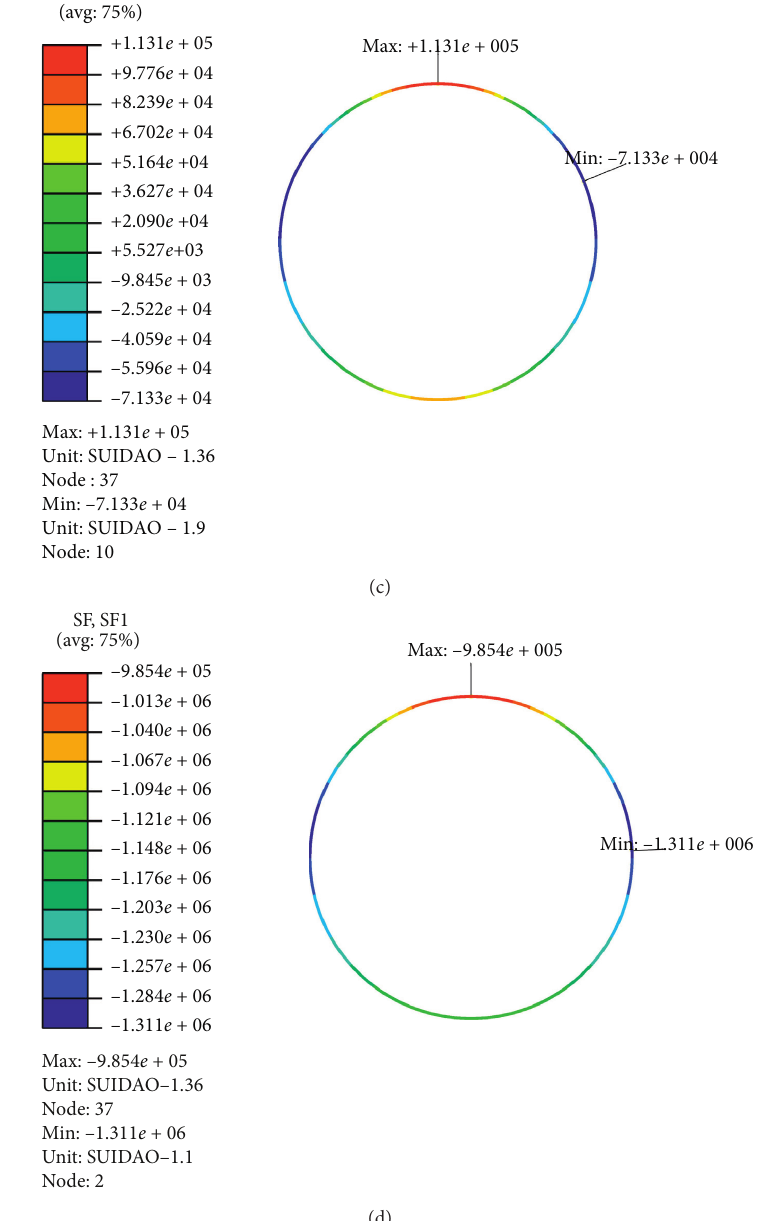
Figure 9: Bending moment and axial diagrams for load mode I. (a) Bending moment diagram under 300kPa (N · m). (b) Axial force diagram under 300kPa (N). (c) Bending moment diagram under 400kPa (N · m). (d) Axial force diagram under 400kPa